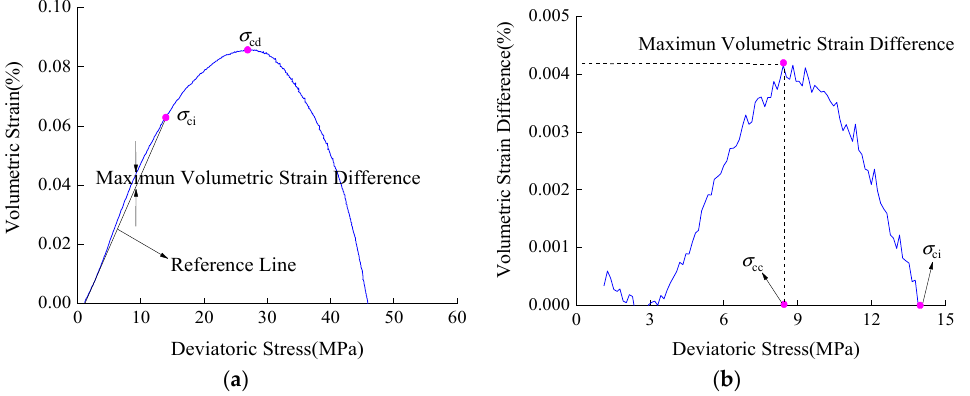
Figure 7. The value of σ cc is determined based on the volume strain difference–deviatoric stress